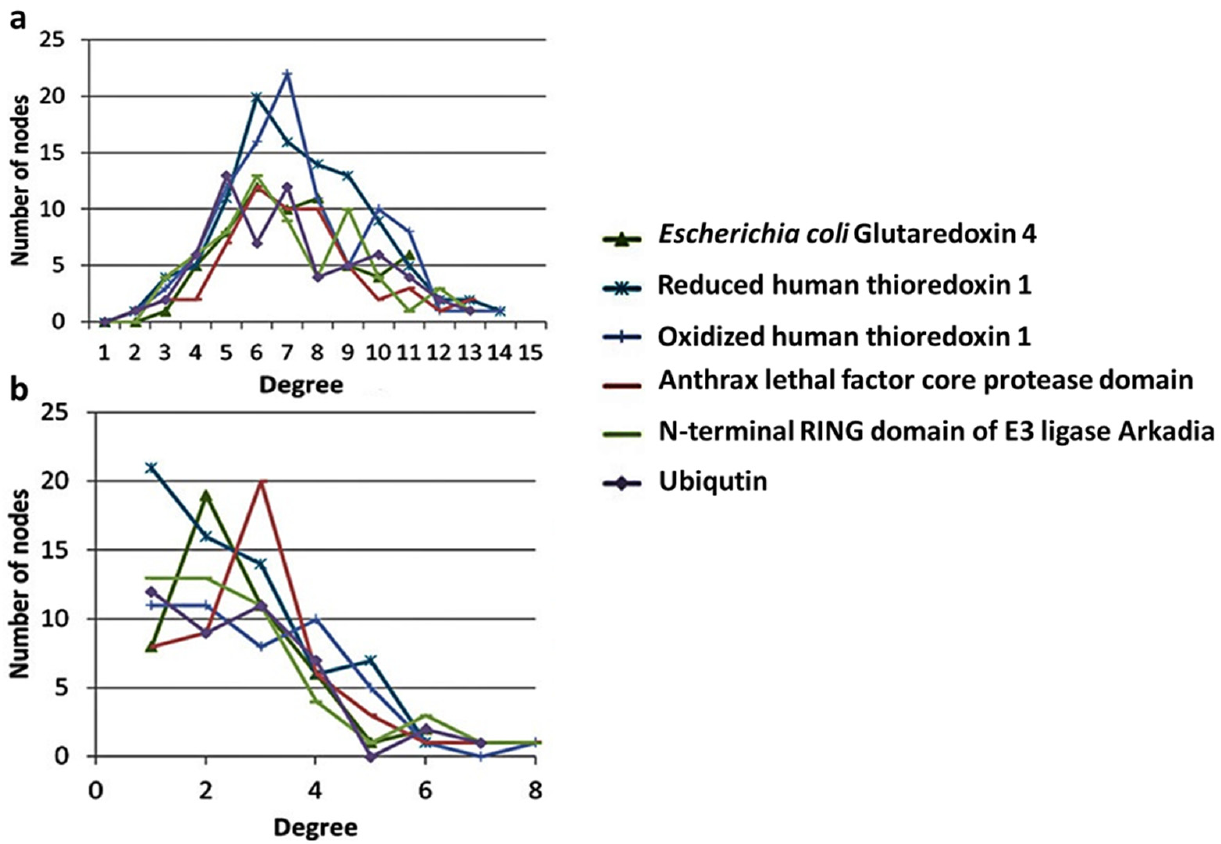
Figure 1. Degree distribution of ( a ) short- and ( b ) long-range interaction networks of six different proteins. Protein contact networks (PCNs) were constructed as described in the Materials and Methods section.